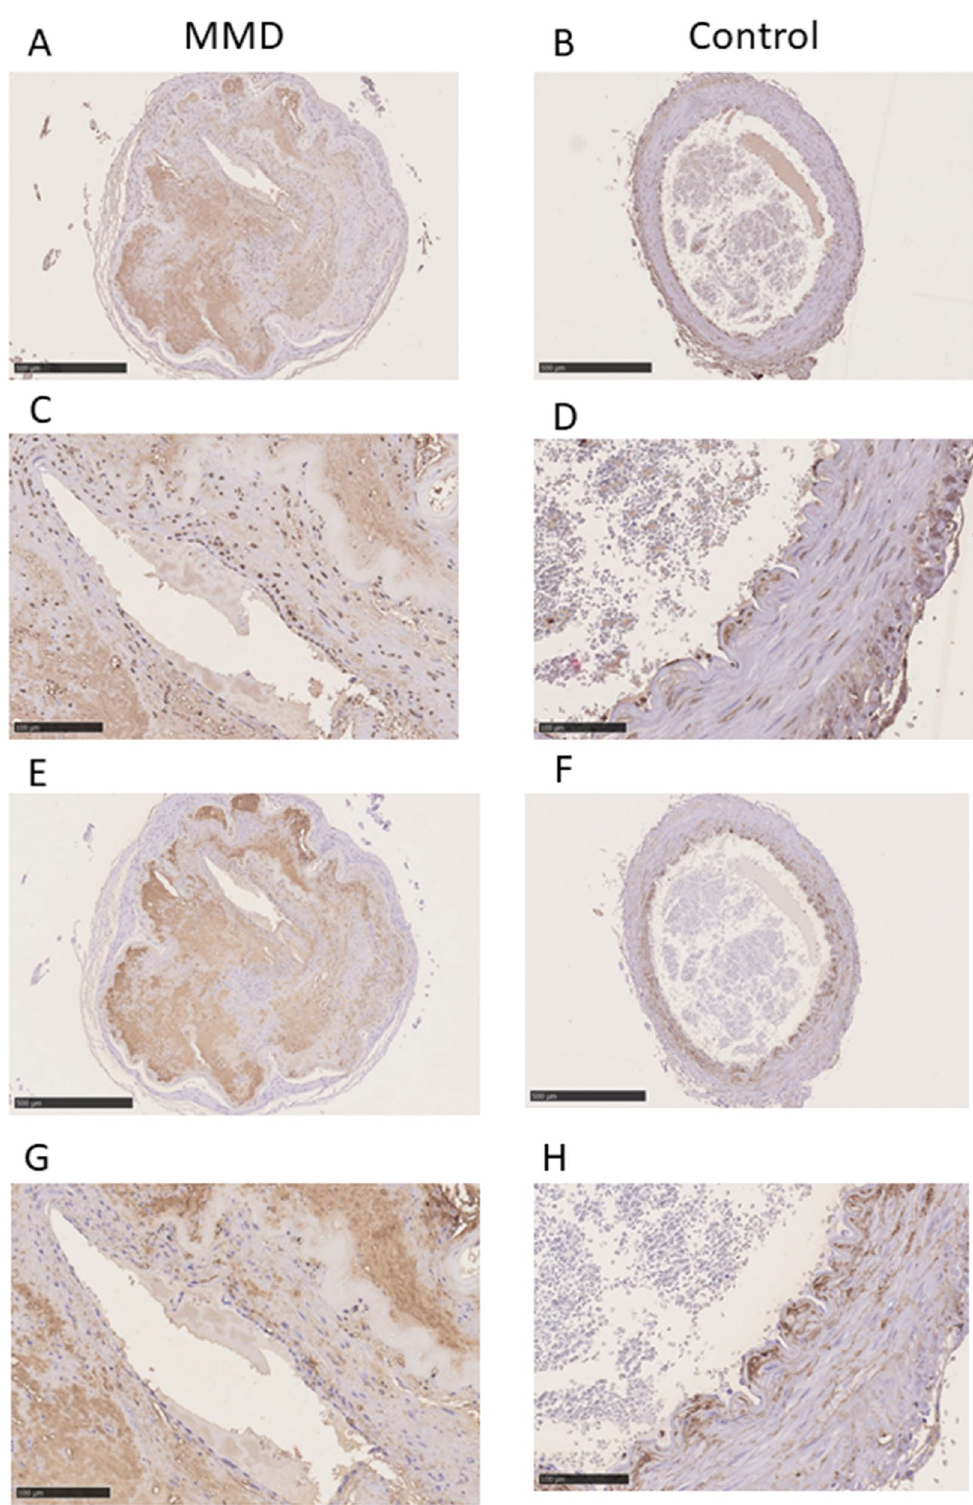
Figure 2. Immunohistochemical staining for CS. In MMD, there was strong staining in the thickened intima, and faint staining in peri-endothelial cells for both CS-C4 (panels A , C ) and CS-C6 (panels E , G ). In contrast, there was stronger staining for both CS-C4 (panels B , D ) and CS- C6 (panels F , H ) in the endothelial cells of controls (arrows). CS-C4, antibodies against chondroitin 4-sulfate (2B6); CS-C6, antibodies against chondroitin 6-sulfate (3B3). Scale bar: 500 μm for ( A , B , E , F ); 100 μm for ( C , D , G , H